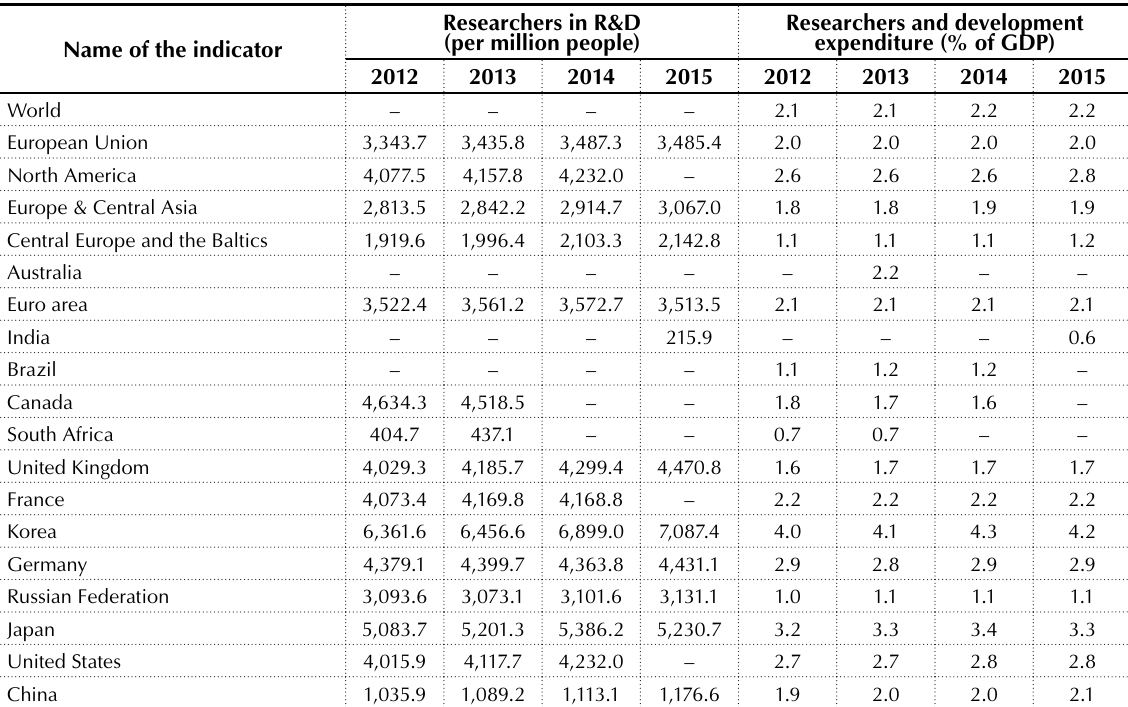
Table 1. Dynamics of the number of researchers in the world Source: the table is compiled by authors with the materials from “World Development Indicators”. Retrieved from